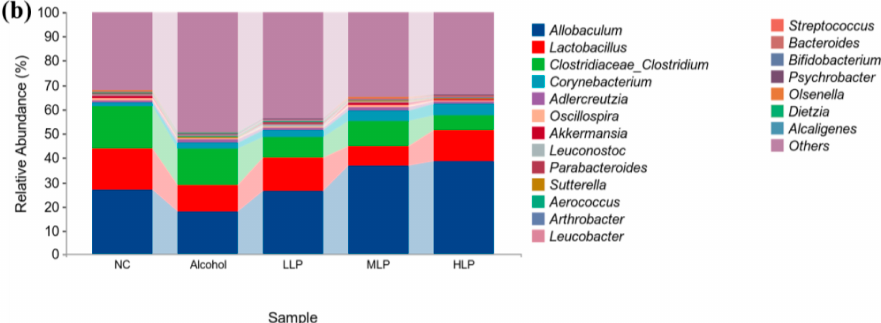
Figure 10. Effects of L. plantarum J26 on microbial composition of the cecal contents. ( a ): microbial composition at the phylum level of the cecal contents a; ( b ): microbial composition at the genus level of the cecal contents. NC, normal control; LLP, low-dose L. plantarum J26; MLP, medium-dose L. plantarum J26; HLP, high-dose L. plantarum J26.